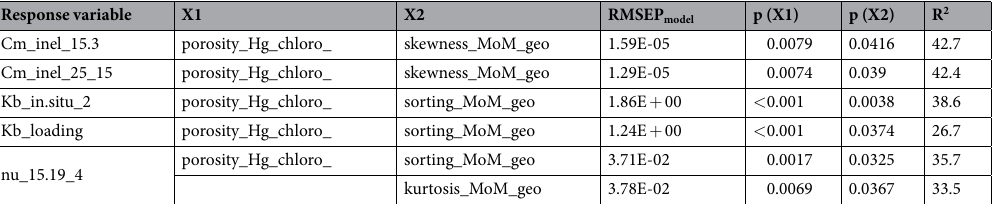
Table 1, all available predictor variables with an associated p-value < 0.05 are listed for each response variable, along with their RMSEP and R 2 values. Some response variables did not have a single predictor variable which